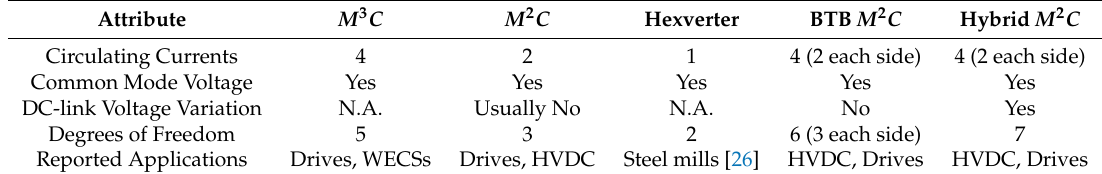
Table 4. Modular multilevel topologies for drive applications. N.A = not